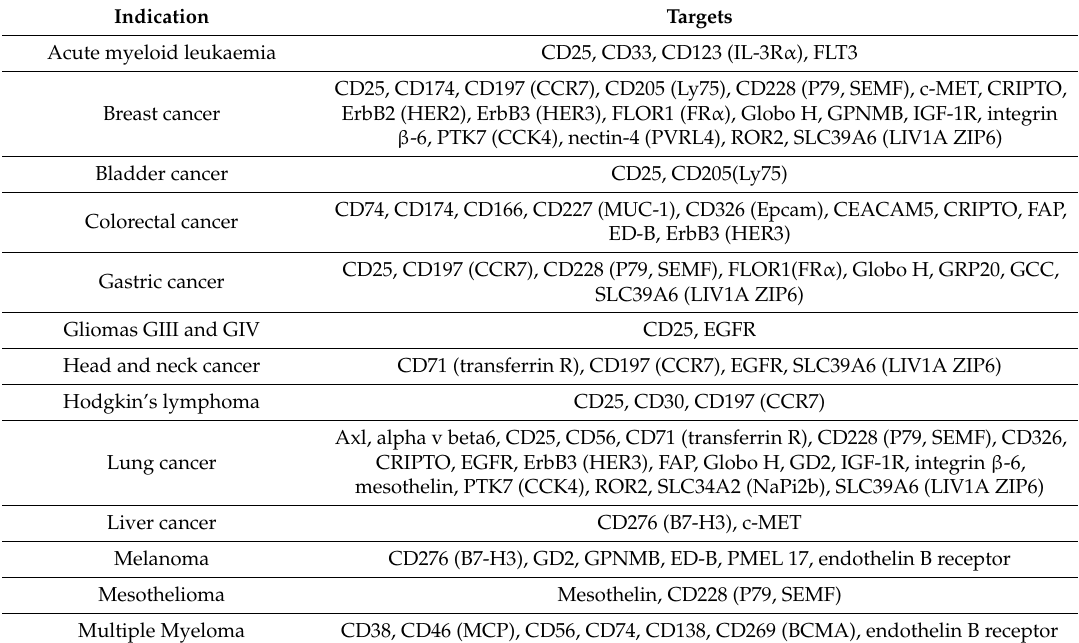
Table 1. Target antigens for ADCs in development and in in the